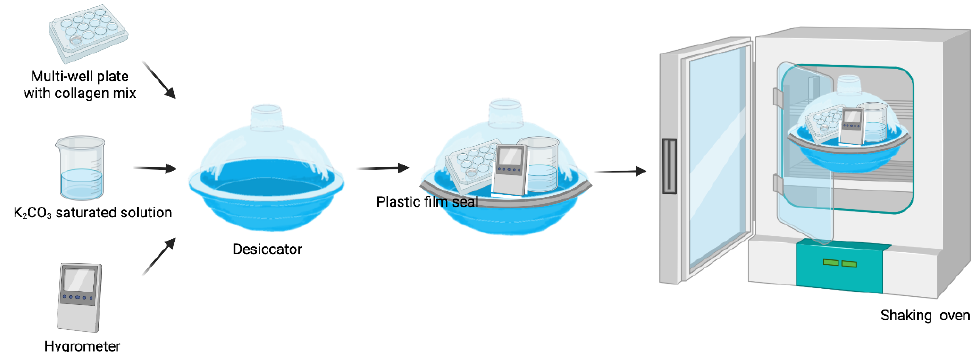
Figure 1. Matryoshka system assembly (created with Biorender.com Available online: https://app.biorender.com (accessed on 21 June 2022)